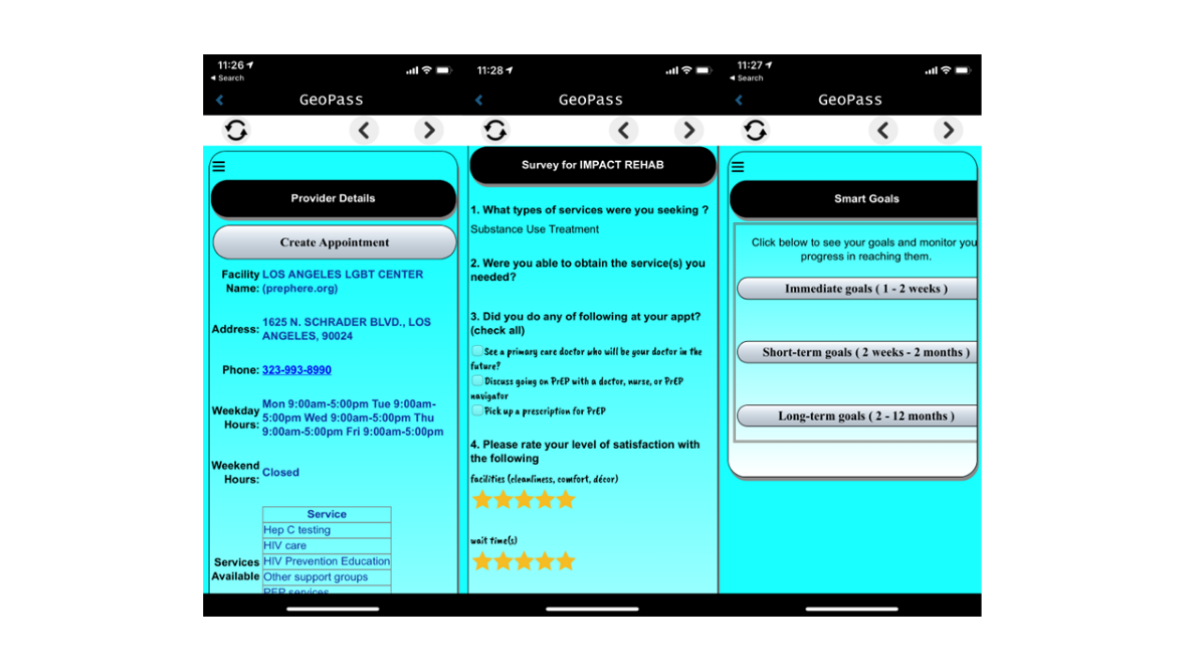
Figure 2. Screenshots of the GeoPass